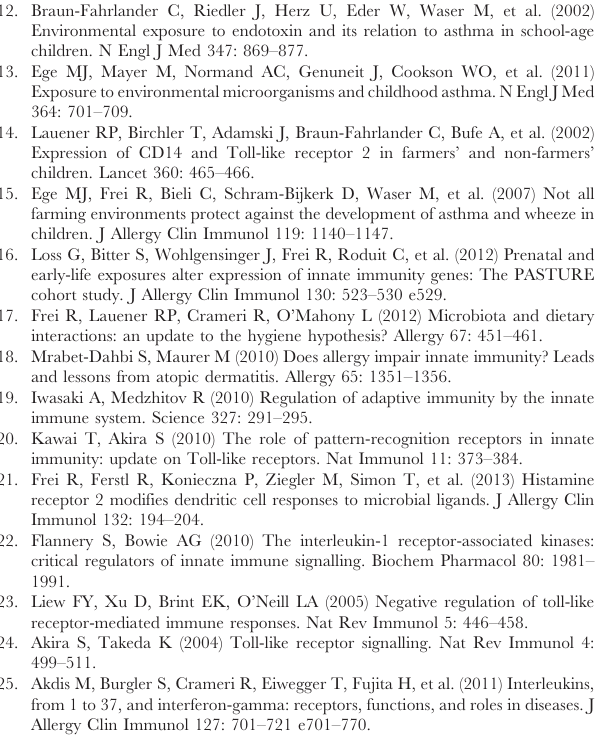
IgE. Table S6, association of farm life with gene expression of APRIL, BAFF, CD40L, and AICDA. Table S7, association of gene expression of APRIL, BAFF, CD40L, and AICDA with asthma, rhinoconjunctivitis, CSR to IgE, and total or allergen- specific